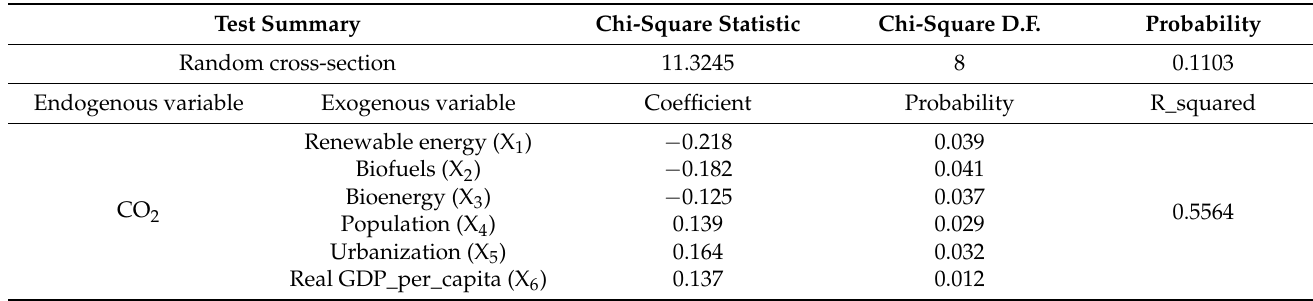
Table 5. Hausman Test